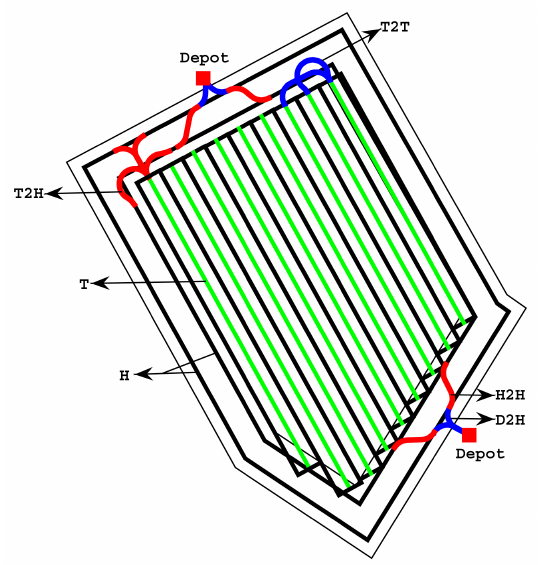
Figure 1. An illustrative example of field representation. H: headland passes; T: fieldwork track; T2H: fieldwork track to headland passes; T2T: fieldwork track to fieldwork track; H2H: headland passes to headland passes; D2H: depot to headland